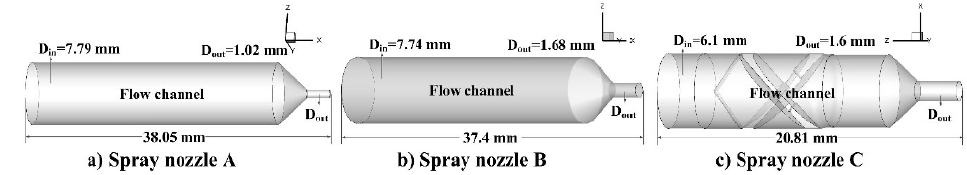
Figure 5. Nozzle geometries tested by [46] with liquid nitrogen. Reprinted from [46], Copyright (2017), with permission from